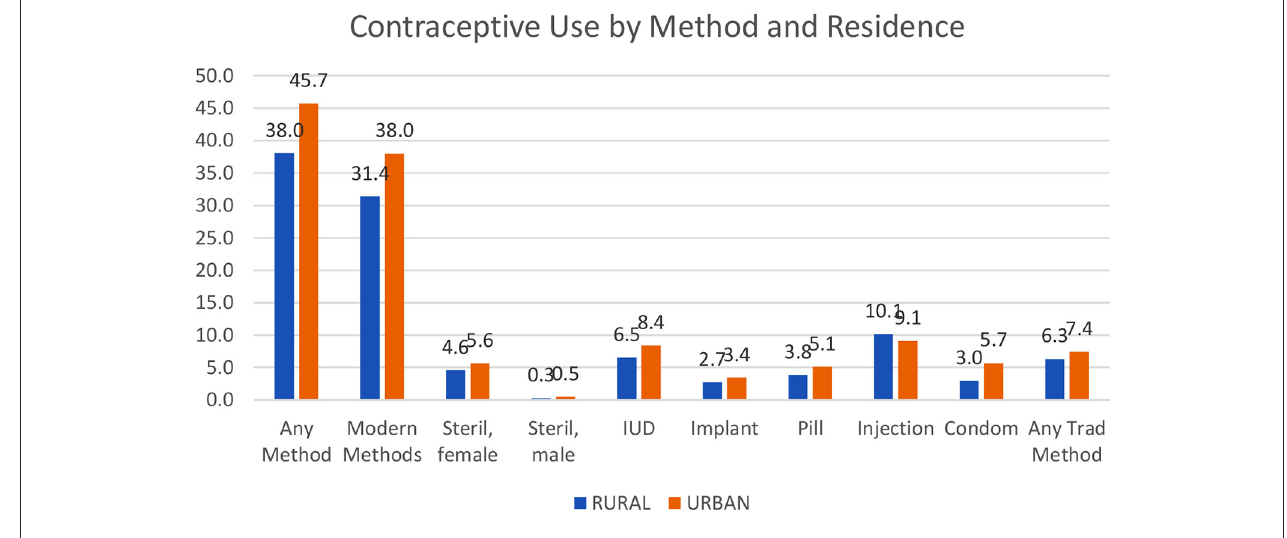
FIGURE 1 | Contraceptive use by method and residence.